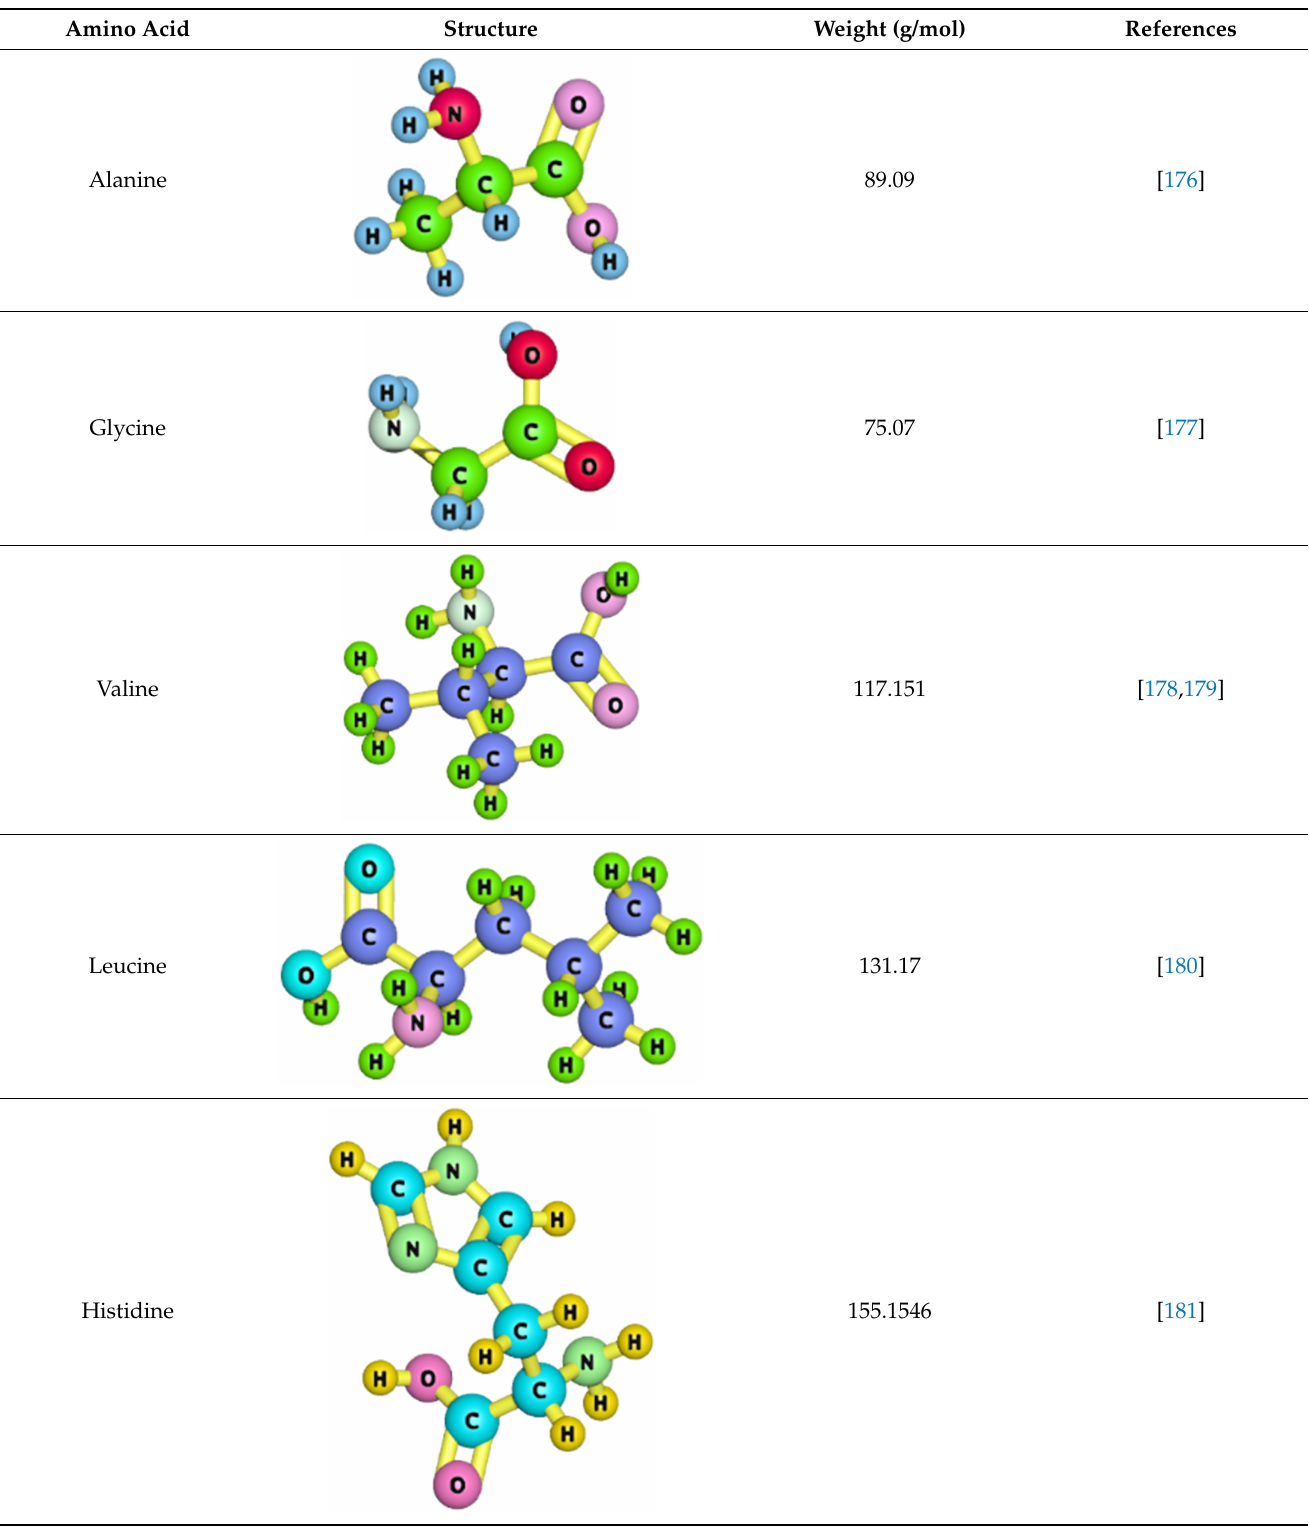
Table 10. Summary of the most widely used amino acids as hydrate inhibitors in the oil/gas